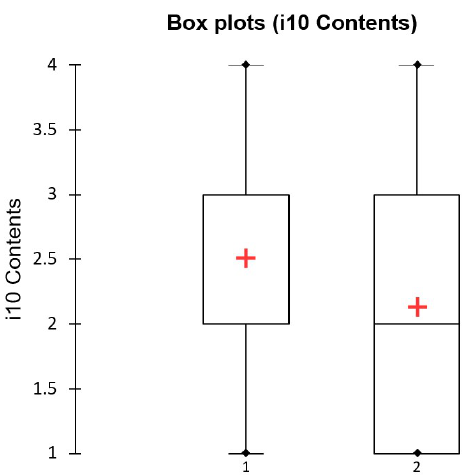
Figure 7. Box plot of the average score of Item 10 (presentation of the contents of the programs) according to whether the program is general or specific.